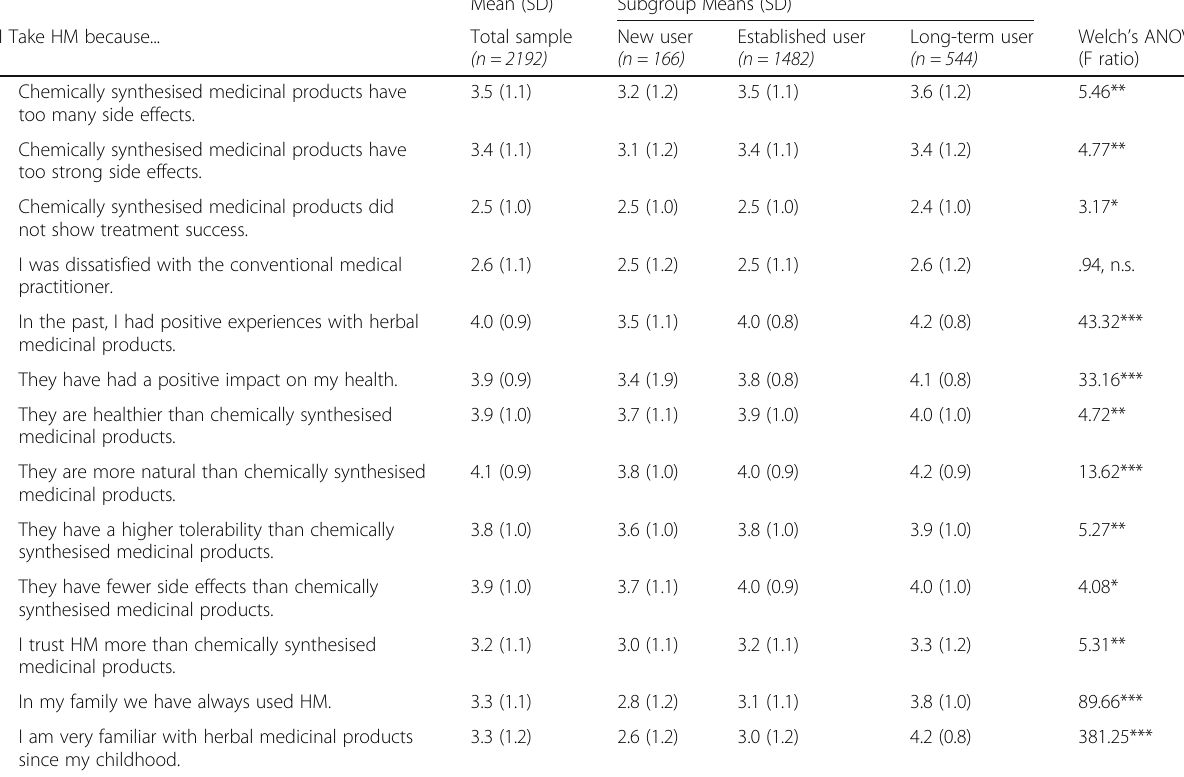
Table 2 Mean values of the agreement of the reasons for HM use and results of Welch ’ s ANOVA comparing the subgroups Mean (SD) Subgroup Means (SD) I Take HM